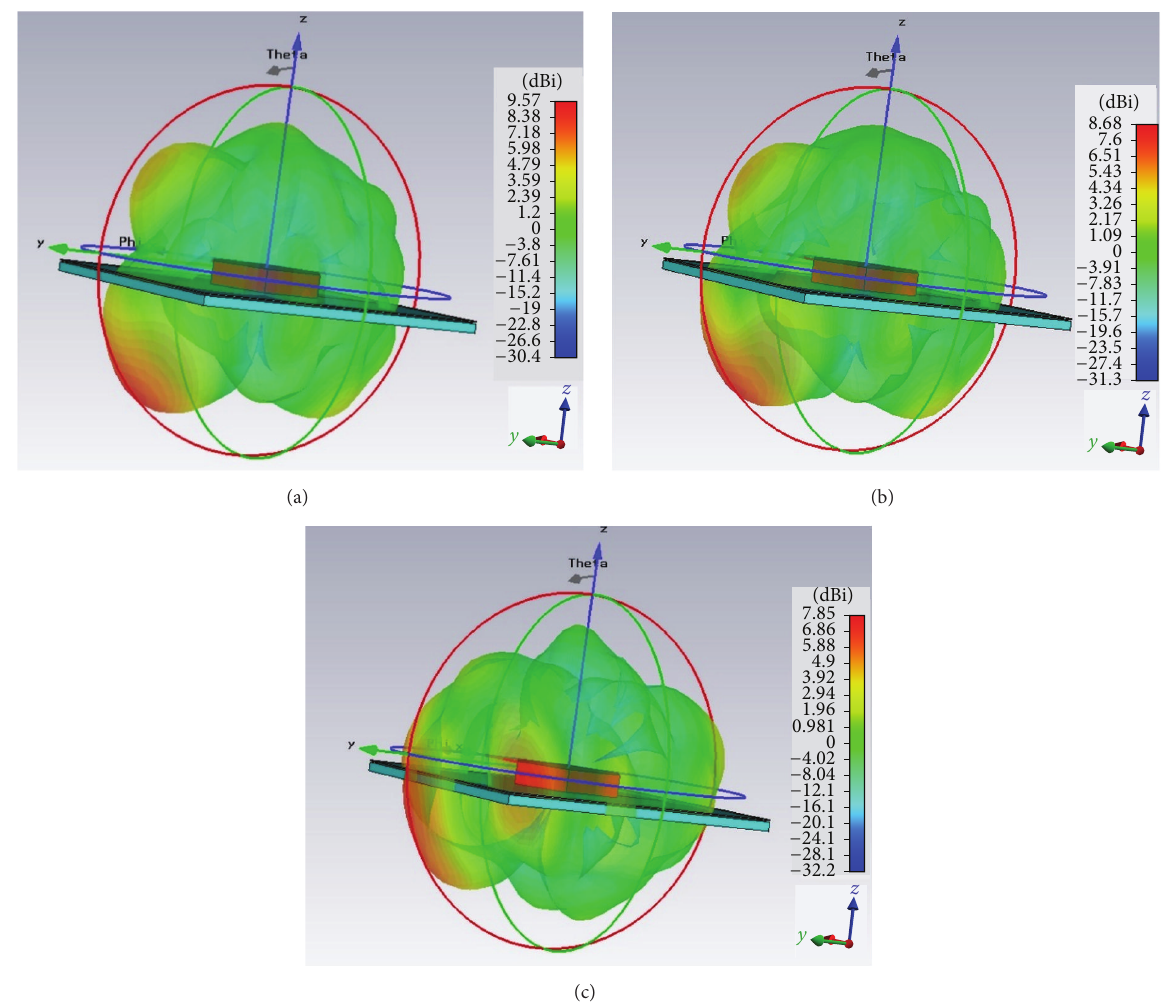
Figure 8: (a) 3D radiation pattern at 191THz. (b) 3D radiation pattern at 193.5 THz. (c) 3D radiation pattern at